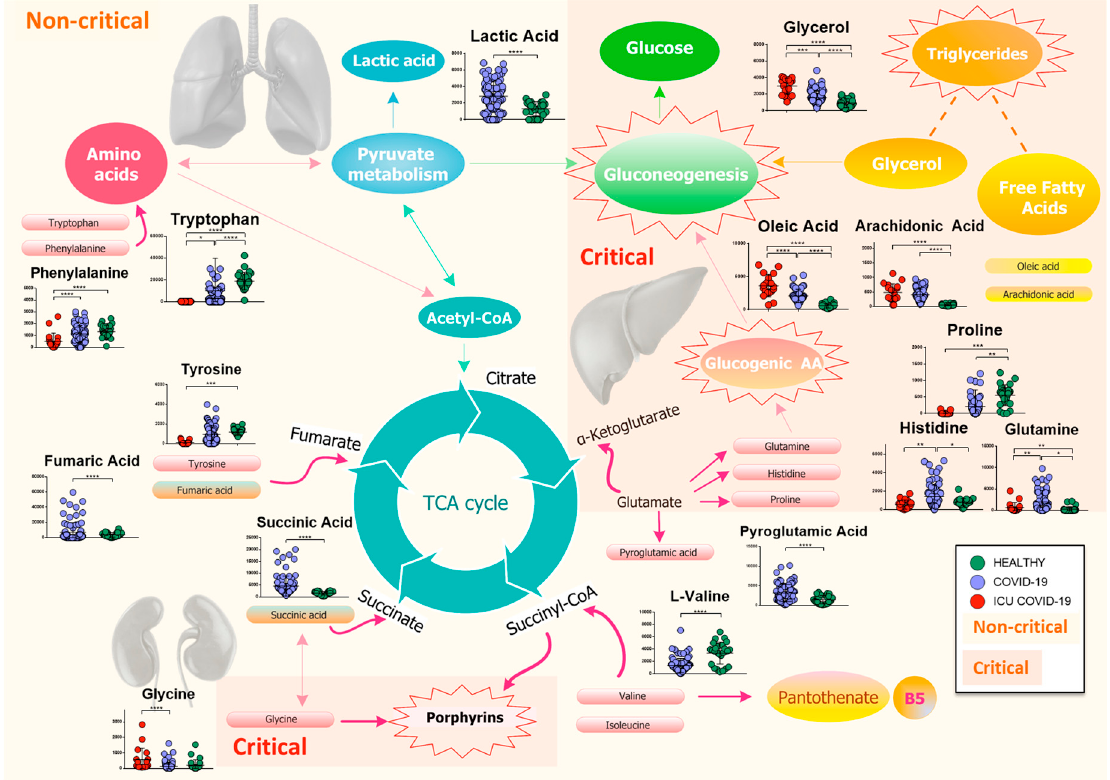
Figure 8. Mapping of di ff erential metabolites related to the major metabolism involved during the progress of the COVID-19 infection. The biochemical map shows the presence of an increase in lactic acid and a consumption of amino acids, which enter the TCA cycle as intermediates of fumarate and succinyl-CoA, in non-critical patients. Isoleucine and l -valine may cause a dysregulation of pantothenate metabolism, resulting in a possible loss of vitamin B5. Meanwhile, pyroglutamic acid, which can be converted into glutamic acid and enter TCA for energy production, increases, as does succinic acid. The severity of the disease is characterized by a drastic decrease in glucogenic amino acids, which are used in the process of gluconeogenesis, while lipolysis of adipose tissue produces glycerol, which is used for the synthesis of glucose, and free fatty acids, such as arachidonic and oleic acids. Finally, the increase in glycine activates the metabolism of porphyrins, which play a crucial role in the progression of the infection. ( p -value < 0.05 = *; p -value < 0.01 = **; p -value < 0.001 = ***; p -value < 0.0001 = ****).